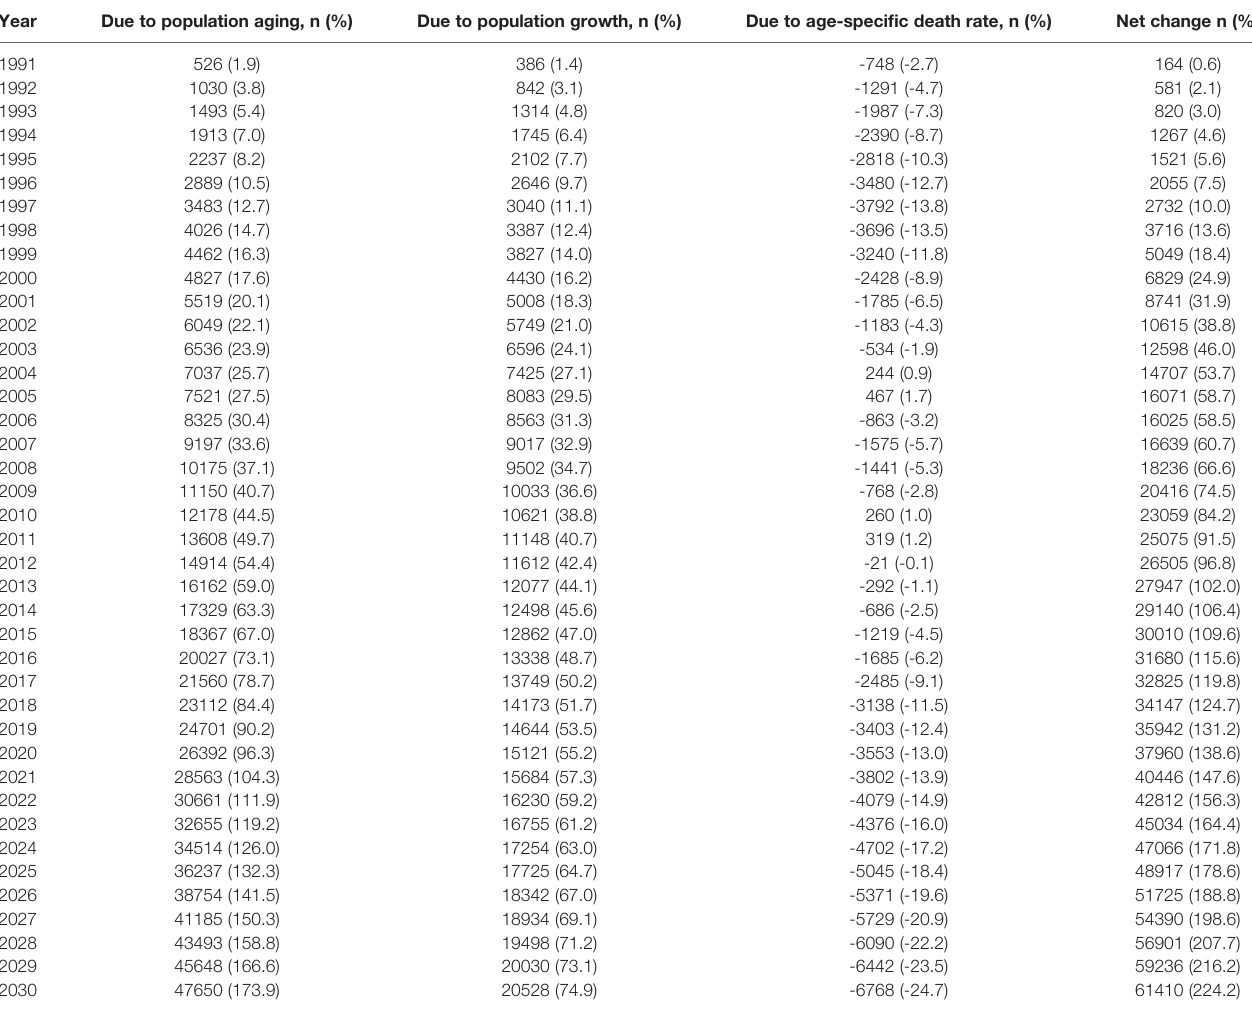
TABLE 1 | Contribution of changes in population aging, population growth, and age-speci fi c death rate of type 2 diabetic kidney disease (DKD) to the net change of DKD deaths in China from 1991 to 2030, using 1990 as the reference year. Year Due to population aging, n (%) Due to population growth, n (%) Due to age-speci fi c death rate, n